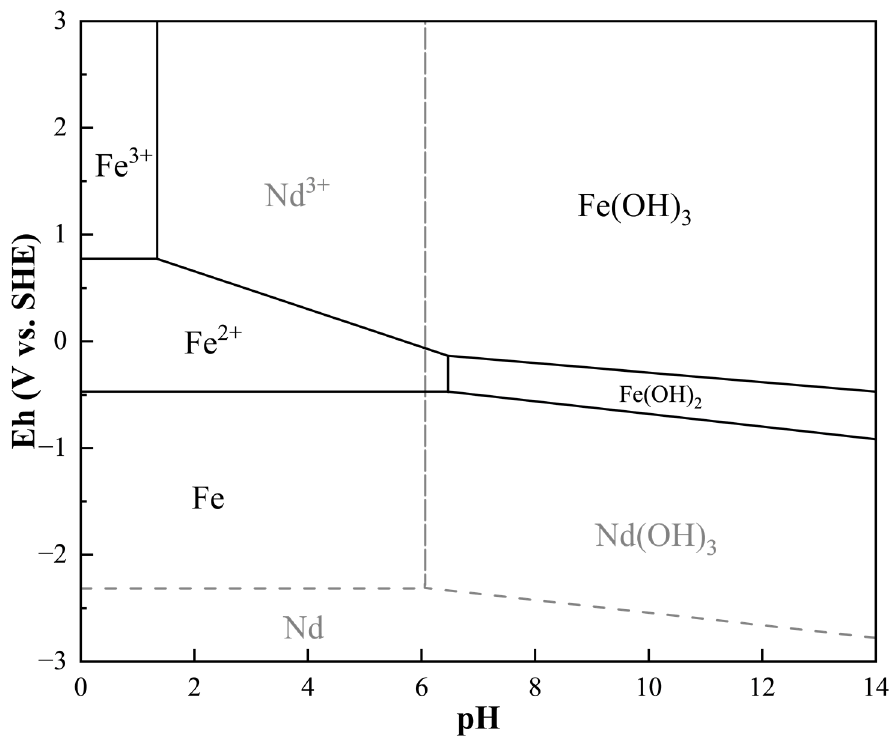
Figure 5. The Eh-pH diagram for the Nd-H 2 O system and the Fe-H 2 O system. [Fe]:1.0 M, [Nd]:1.0 M.